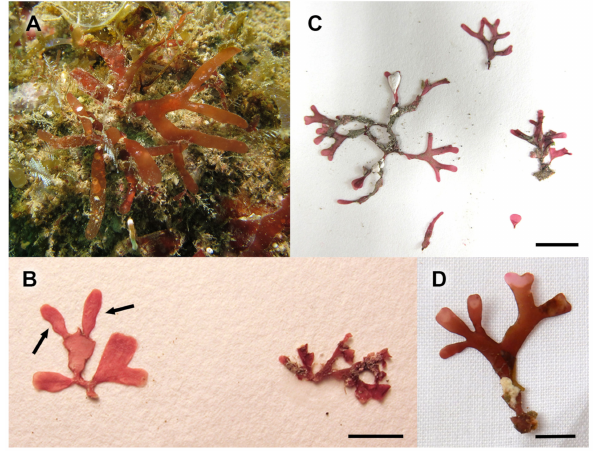
Figure 2. Gracilaria parva sp. nov. ( A ) In situ image of specimen PHYKOS-6870, Isla Cebaco, Panama. ( B ) Pressed holotype, WNC-34055, Isla Burica, Panama. Arrows indicate new branches with constricted bases developing from a wound site. Scale = 0.5 cm. ( C ) PHYKOS-6833 herbarium specimen WNC-34185, Isla Cebaco, Panama. Scale = 1.0 cm. ( D ) Specimen from La Chocolatera, Ecuador before splitting and pressing as NCU-675207 and USFQ #438. Scale = 0.5 cm.